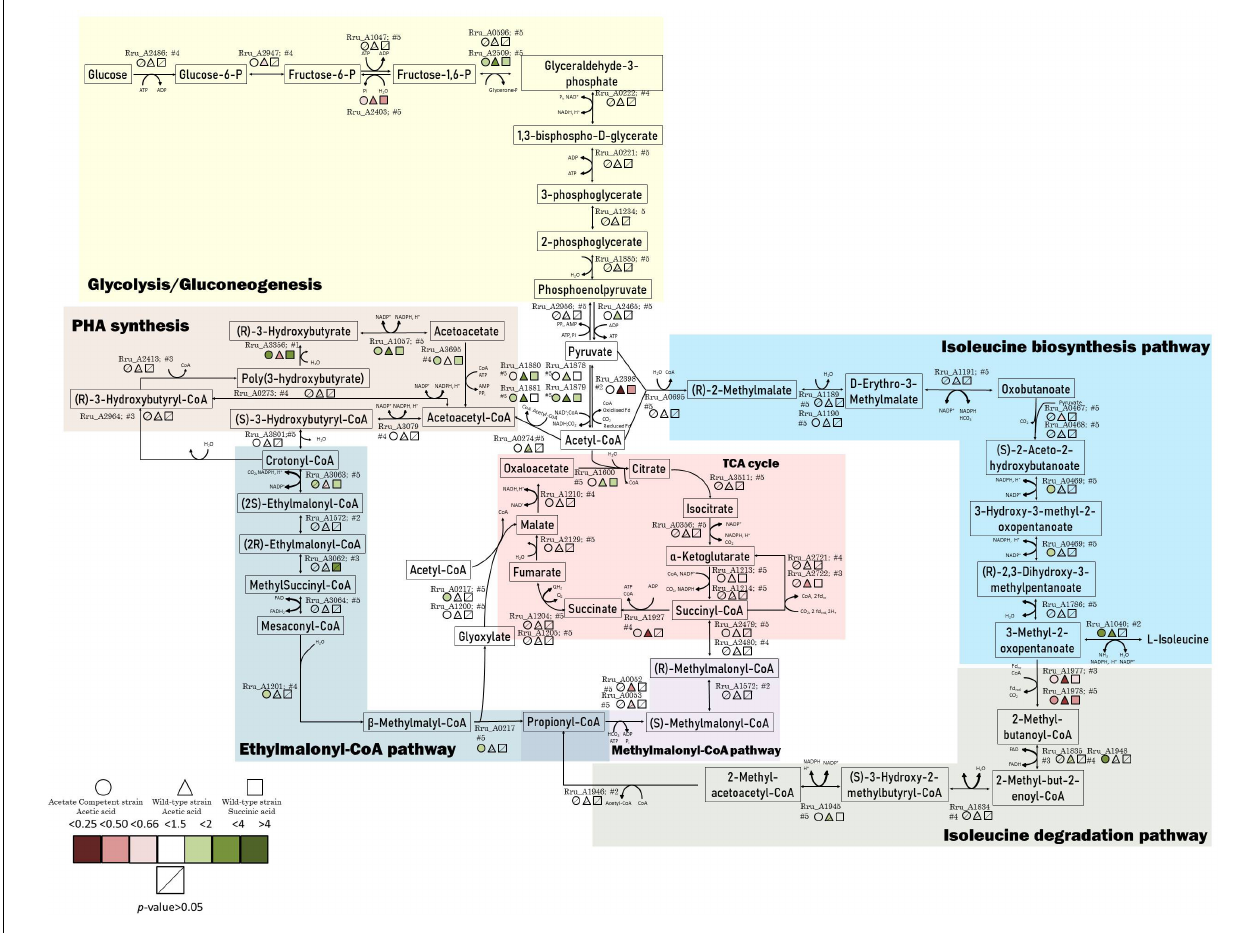
FIGURE 5 | Schematic representation of the central carbon metabolism highlighted by the proteomic data. The colored markers represent the fold change, ranging from red (lower relative abundance) to green (higher relative abundance), of proteins identified and quantified with 2 or more peptides. Different conditions are represented by different forms. Stripped forms depict p >